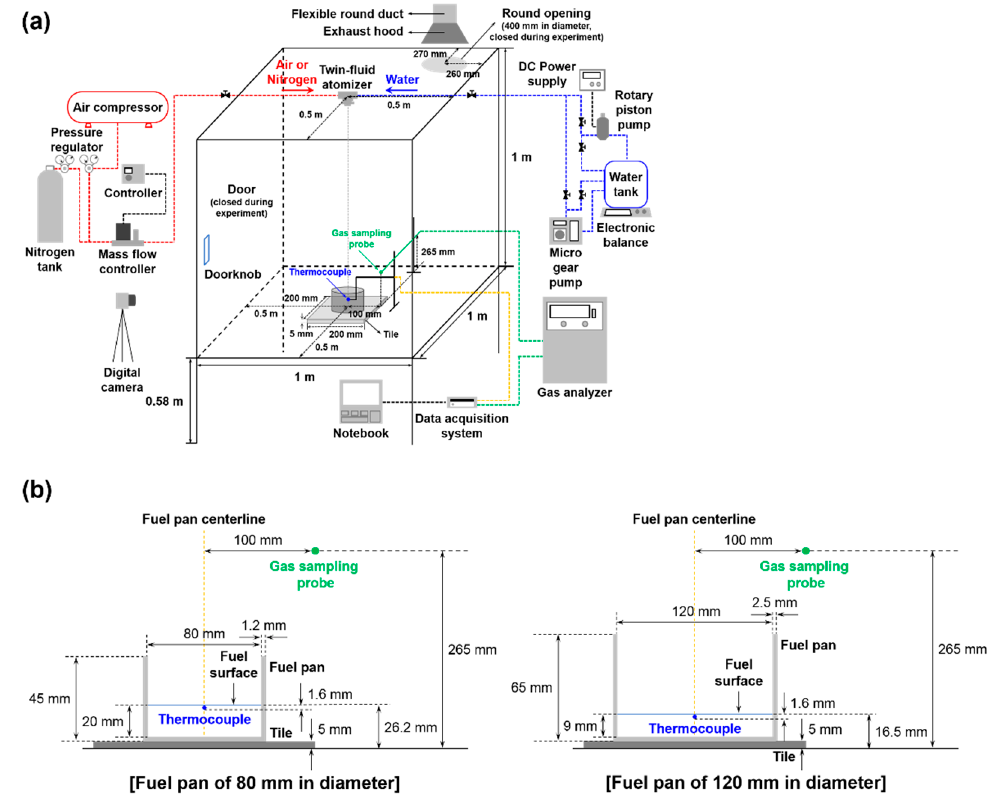
Figure 1. Schematic diagrams of experimental setup and measurement locations for fire extinguishment: ( a ) experimental setup and ( b ) measurement locations.